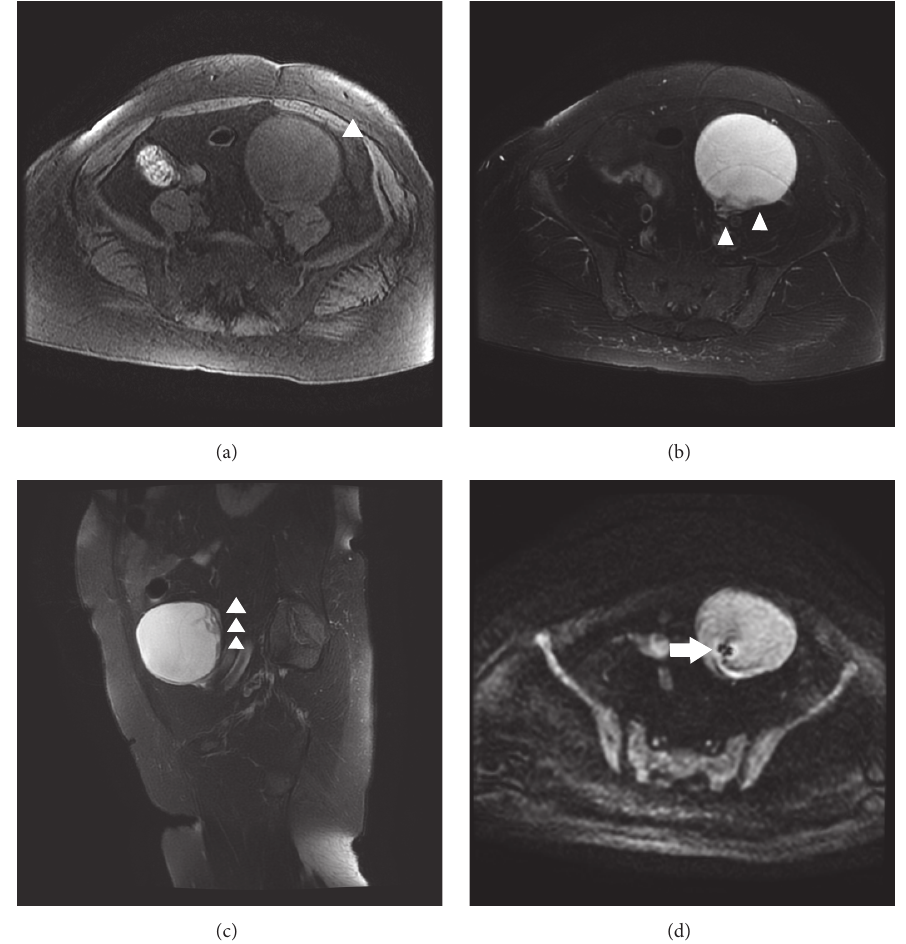
Figure 1: Magnetic resonance imaging findings. (a) T1-weighted transverse image, revealing an ovarian mature cystic teratoma (arrowhead). T2-weighted transverse (b) and sagittal (c) images, demonstrating heterogeneous signal intensity at the posterior wall (arrowheads). (d) Diffusion-weighted transverse image, demonstrating low signal intensity at the septum